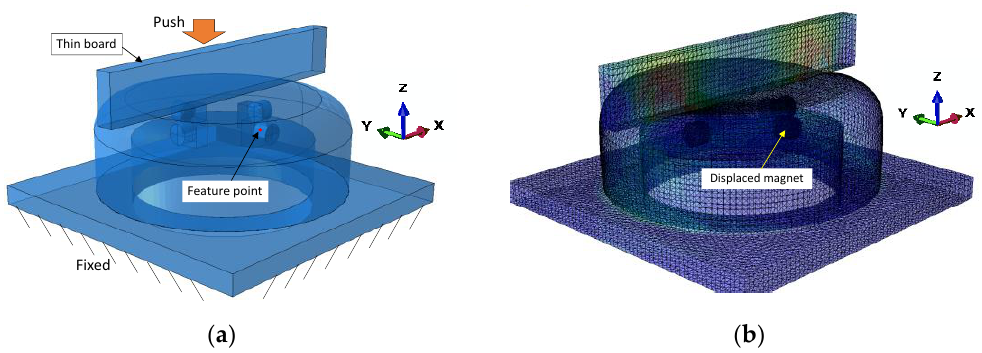
Figure 5. Simulation result: ( a ) initial condition and ( b ) fingertip deformation under a push displacement of 1.0 mm of thin board onto the fingertip.